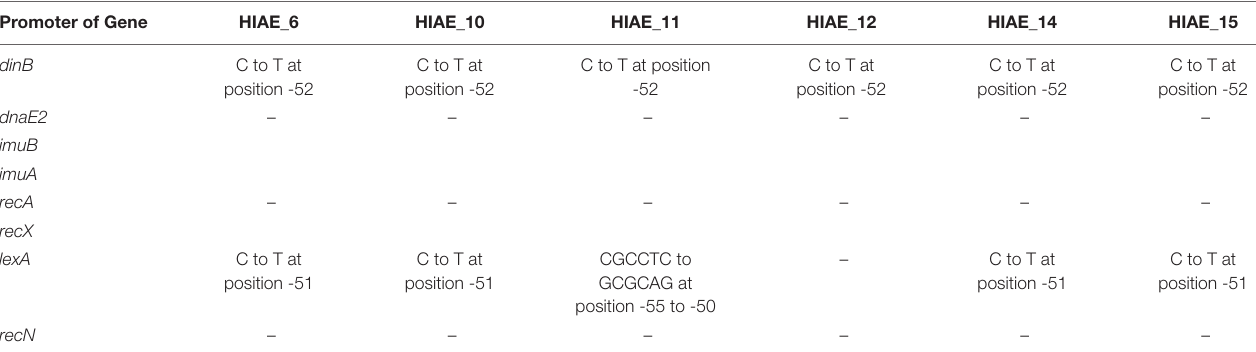
TABLE 5 | SNPs identified in the putative promoter region of adaptive-response related genes of clinical isolates compared to PA14-UCBPP strain. Promoter of